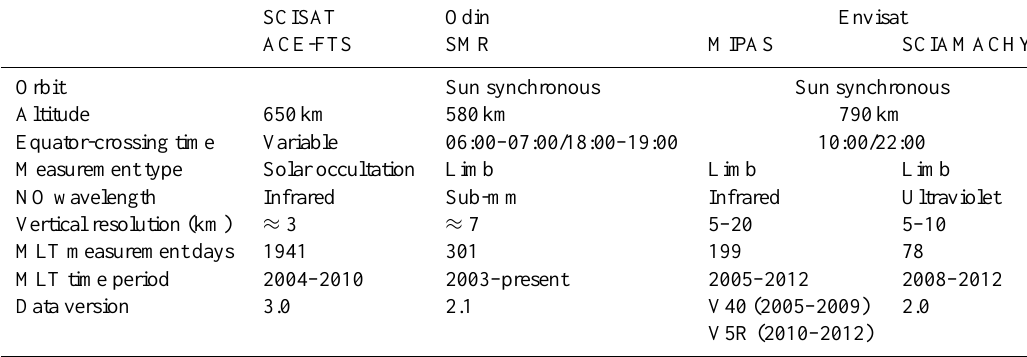
Table 1. Instrument overview